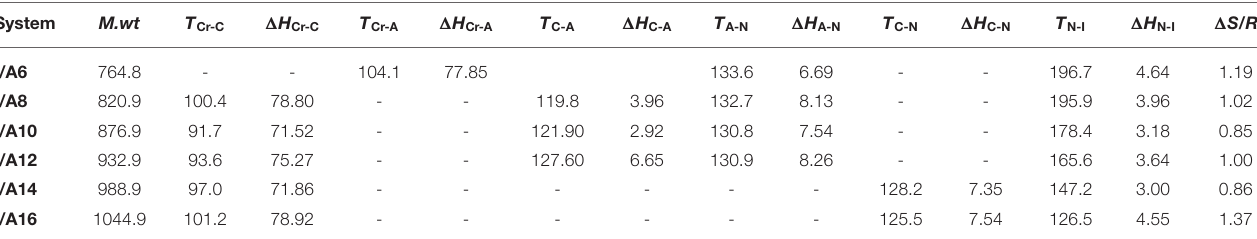
TABLE 1 | Phase transition temperatures ( ◦ C), enthalpy of transitions ( 1 H , kJ/mol), and normalized entropy of transition ( 1 S /R) for the supramolecular complexes I/A n .